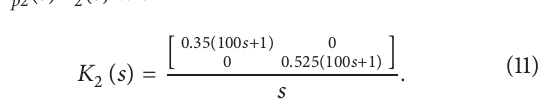
obtain the open loop system 𝐺 𝑜2 (𝑠) = 𝐺 𝑝2 (𝑠)𝐾 2 (𝑠) = (𝑠)𝐾 (𝑠)𝐾 (𝑠) with 𝐺 2 𝑝2 2